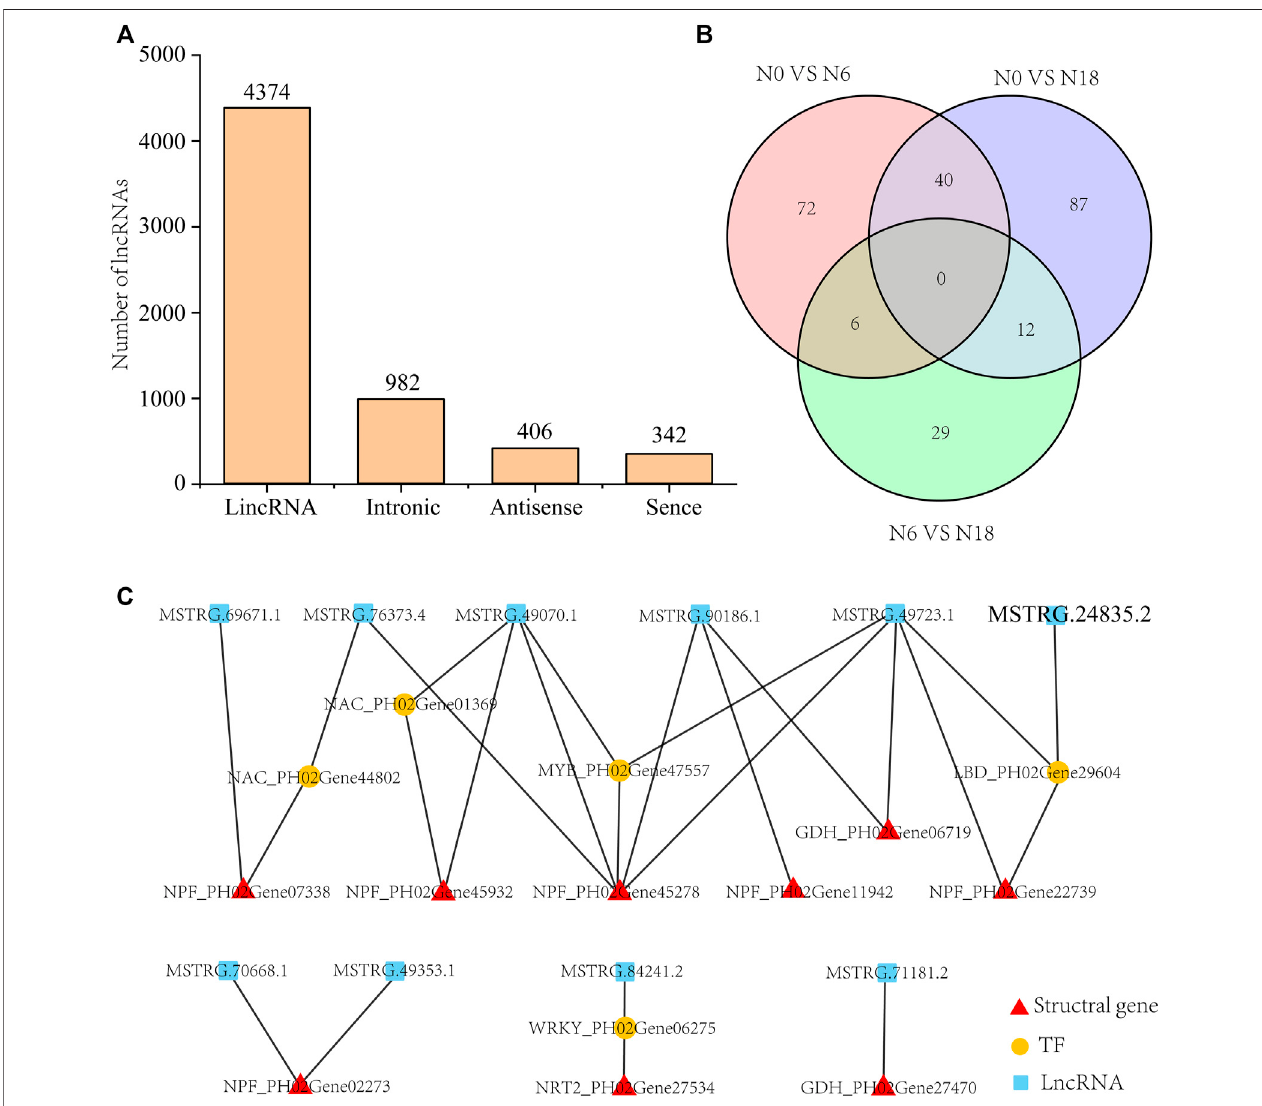
FIGURE6 | Analysis ofDELs and their targeted genes: (A) category and number statistics of lncRNAs; (B) Venn diagram ofDELs from N0 vs . N6, N0 vs .N18, and N6 vs . N18; (C) DEL-DEG pairs involved in nitrogen metabolism.